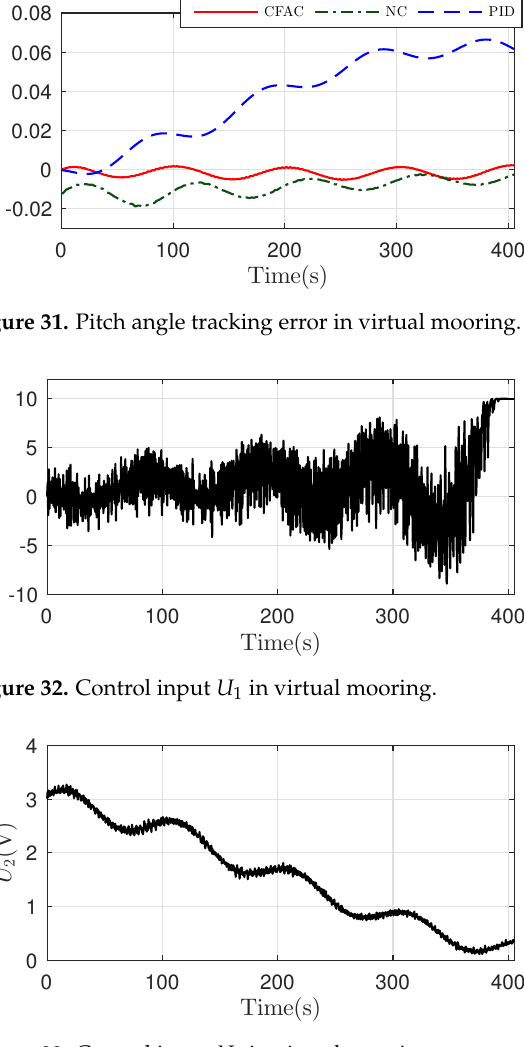
Figure 33. Control input U 2 in virtual